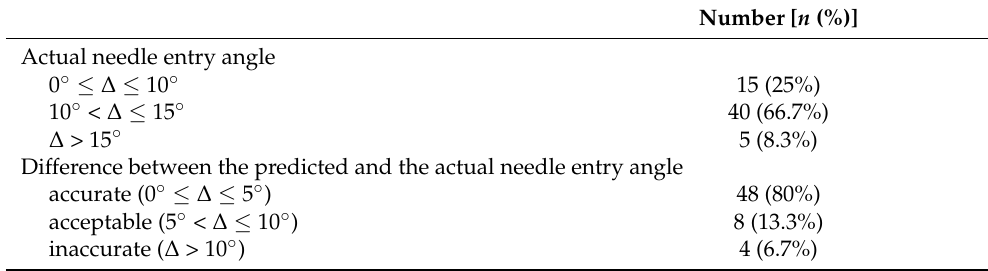
Table 4. Angulation information obtained in Group